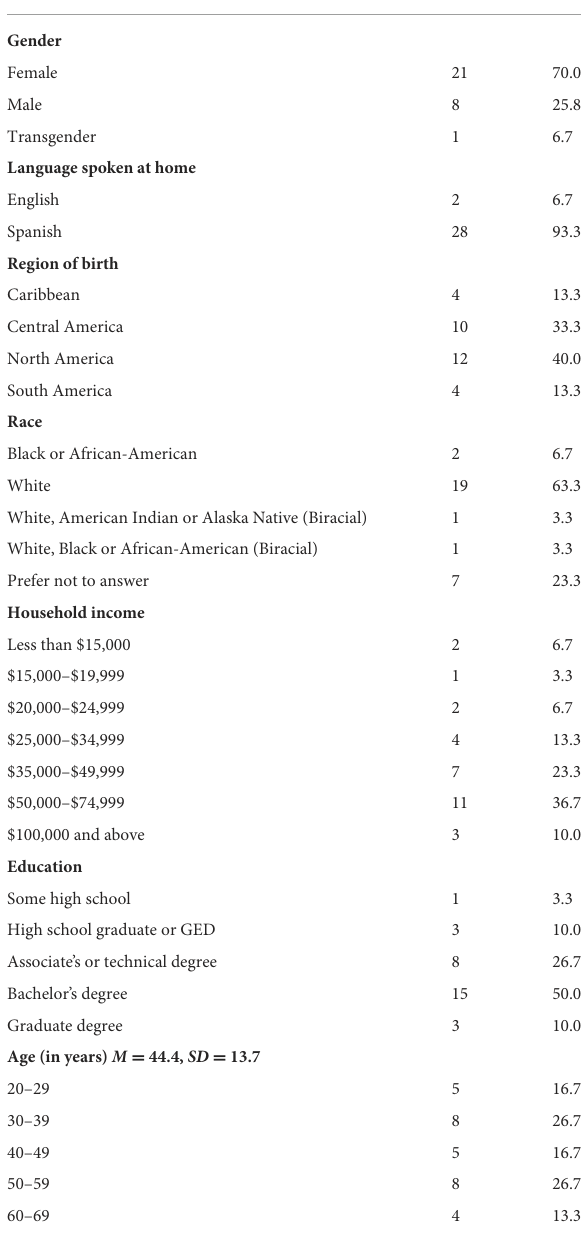
TABLE 1 Characteristics of